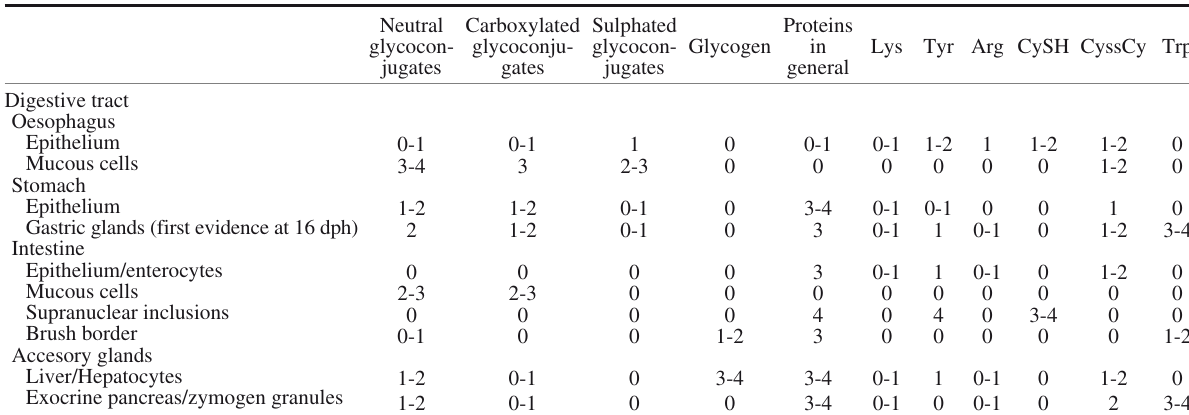
Table 5. – Histochemical distribution of glycoconjugates and proteins during the exogenous feeding phase (14-22 dph) of Chelon labrosus. Results are expressed as semiquantitative assessment of colour intensities or histochemical reactivity. Estimated scale to evaluate the presence of macromolecules: 0, negative or unreactive; 1-2, weak-moderate staining; 3-4, strong